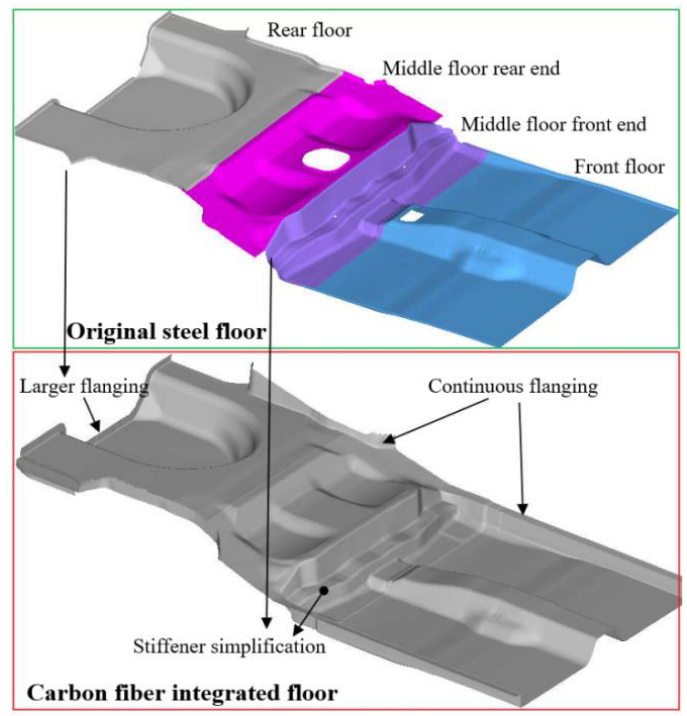
Figure 13. Structure integrated design of the CFRP floor.